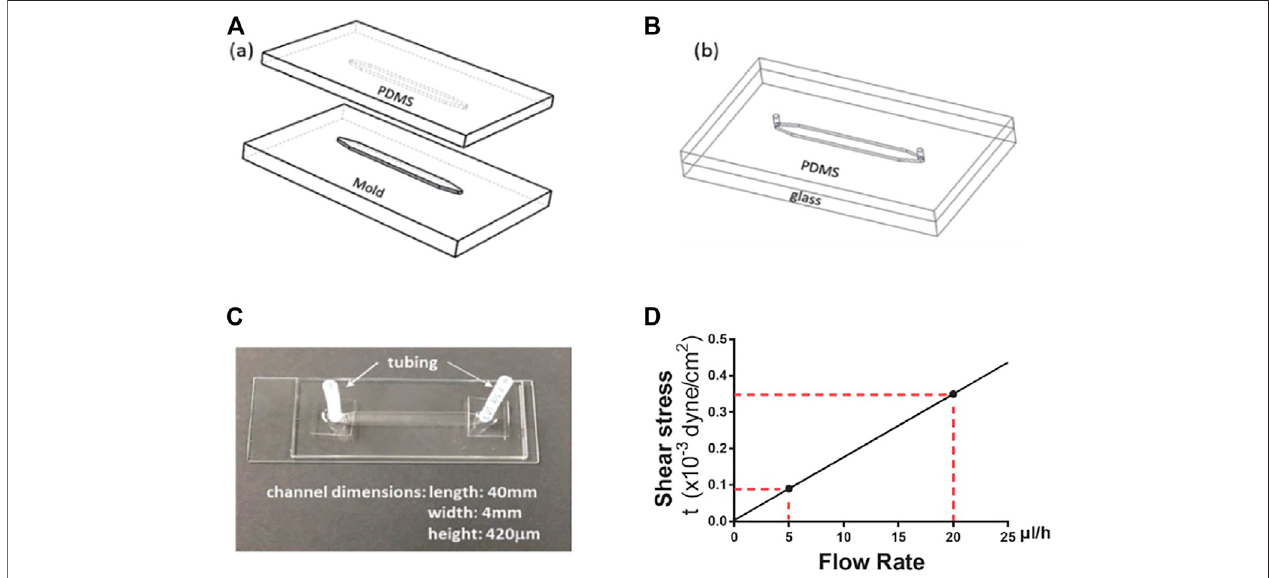
FIGURE 1 | Microdevice fabrication and dimensions. (A) aluminum mold and PDMS replicate. (B) PDMS microchannel bond onto a glass slide. (C) A micro fl uidic devicewiththemicrochanneldimensions. (D) Thelineardependence ofwallshearstresson fl uid fl owrate.Thereddottedlinesindicatethewallshearstresslevelsatthe fl ow rates of 5 and 20 μ l/h, respectively.